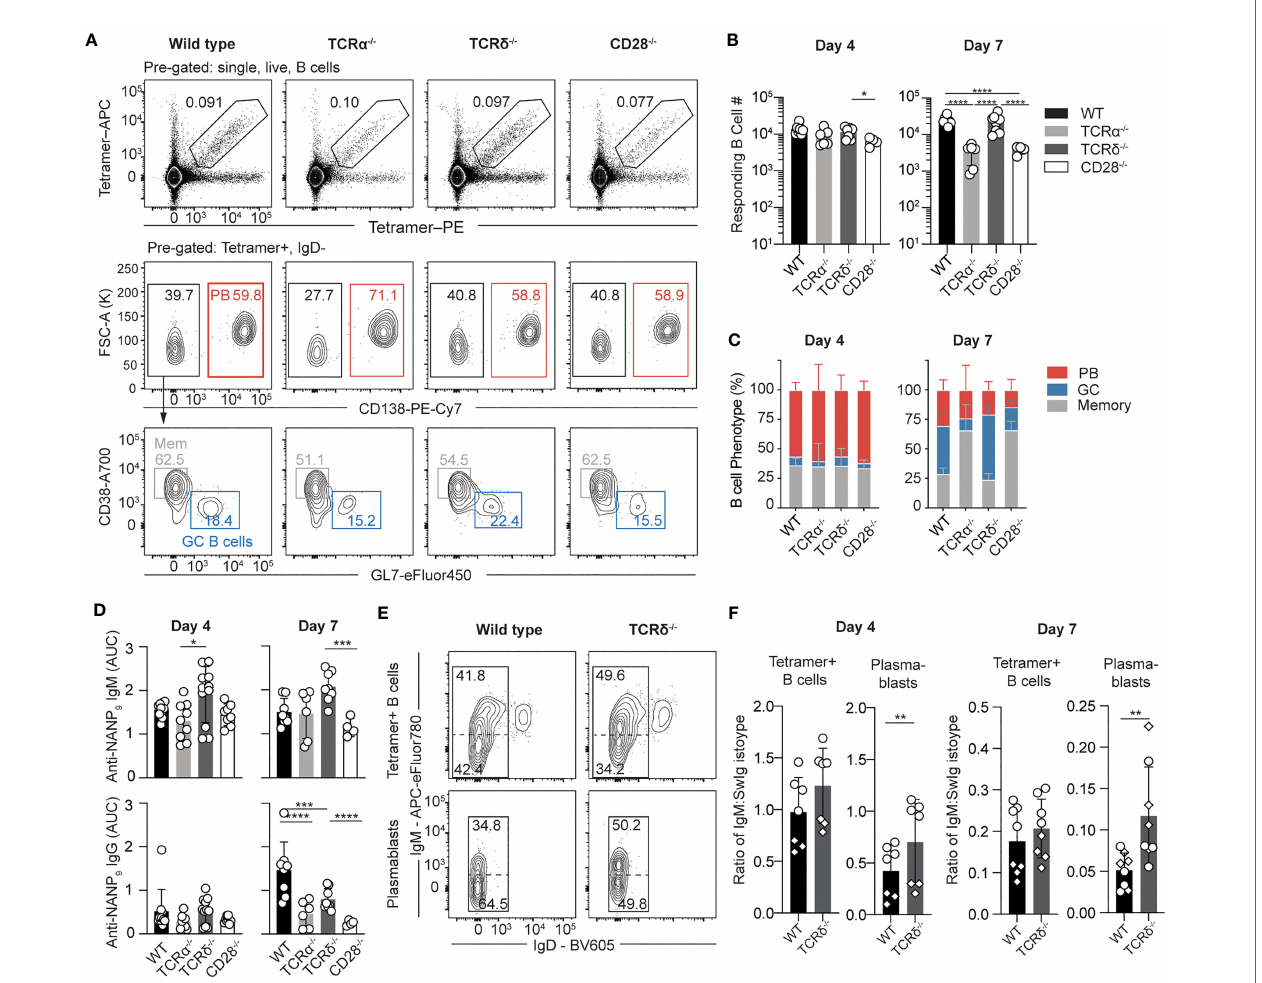
FIGURE 3 | The early Pf CSP-speci fi c B cell response is largely T-independent. TCR a -/- , TCR d -/- , CD28 -/- and wild type (C57BL/6 – WT) mice were immunized with 5 x 10 4 Pb-Pf CSP SPZ i.v. and the B cell and antibody response assessed 4 and 7 days post-immunization. (A) Representative fl ow cytometry plots showing the gating strategy used for identi fi cation of Igh g2A10 B cells and subsequent B cell populations. Pre-gated upon singlets, lymphocytes, Dump-negative, B cells [CD19 + ± CD138 + ]. (B) Quanti fi cation of total splenic Igh g2A10 B cell numbers from fl ow cytometry data at day 4 and 7 post-immunization. (C) Phenotype of Igh g2A10 B cells. (D) IgM and IgG anti- Pf CSP